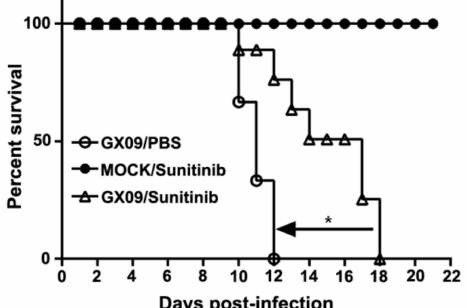
Figure 6. Sunitinib prolongs the survival of mice challenged with RABV street virus GX09. Three groups of ten C57BL / 6 mice each, challenged with GX09 and treated with PBS ( with sunitinib ( (cid:8) ), or challenged with GX09 and treated with sunitinib ( (cid:52) ), were observed for survival post-challenge. All mice were treated once daily for five days with sunitinib or PBS. The log-rank (Mantel-Cox) test was used to analyze statistical di ff erences between the survival rates of the challenged mice. *, p < 0.05; n.s., not